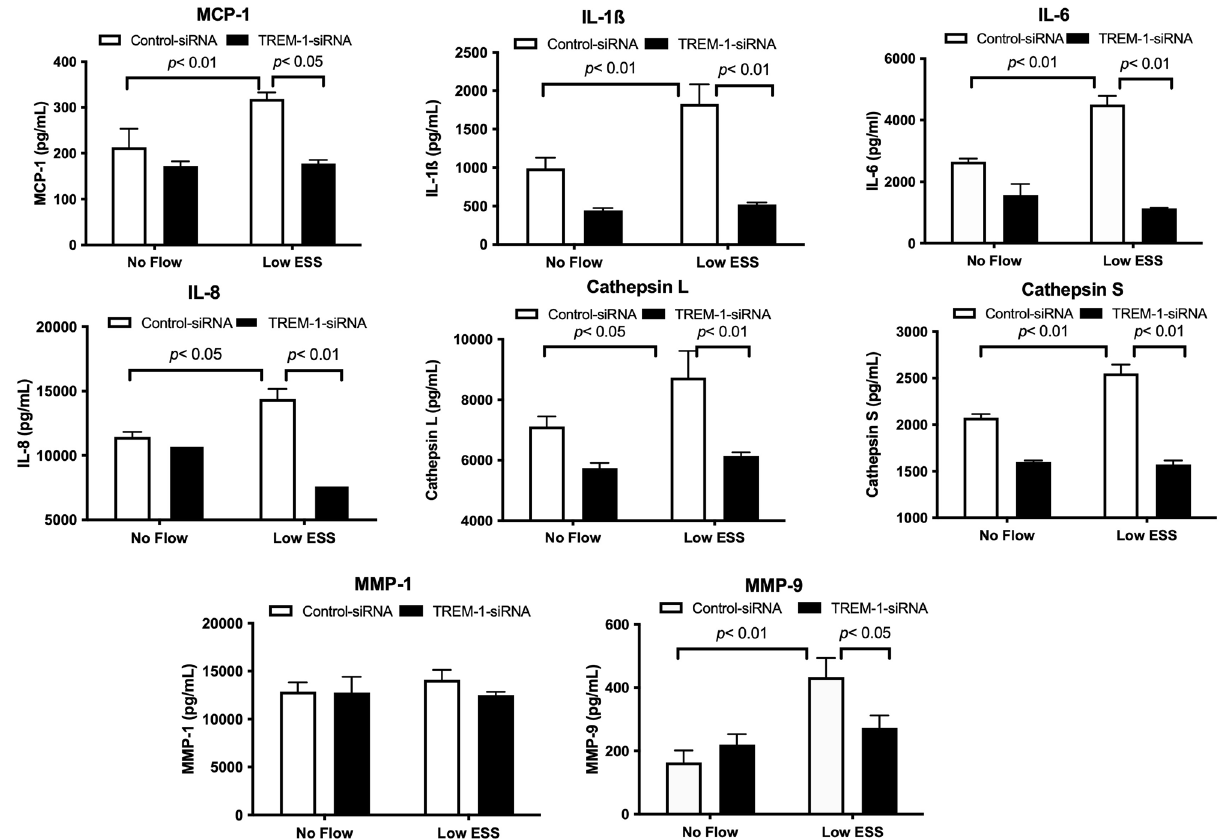
Figure 7. Effect of TREM-1 suppression by siRNA on the protein expression by ELISA of pro-inflammatory molecules and matrix-degrading enzymes after the exposure of the co-culture to low shear stress. HCAECs, HCASMCs, and THP-1 cells were transfected with control-siRNA or TREM-1-siRNA for 6 h. 3D co-culture was prepared on the coverslips and cultured overnight. Cells were then exposed to low ESS or no flow for 1 h followed by additional culture for 5 h. Proteins in the culture medium were quantified by an ELISA as described in the “Methods”. TREM-1: triggering receptor expressed on myeloid cells-1, siRNA: small interfering RNA, IL: interleukin, MMP: matrix metalloproteinase, MCP-1: monocyte chemoattractant protein-1, HCAECs: human coronary artery endothelial cells, HCASMCs: human coronary artery smooth muscle cells. Data were averaged over 3 separate